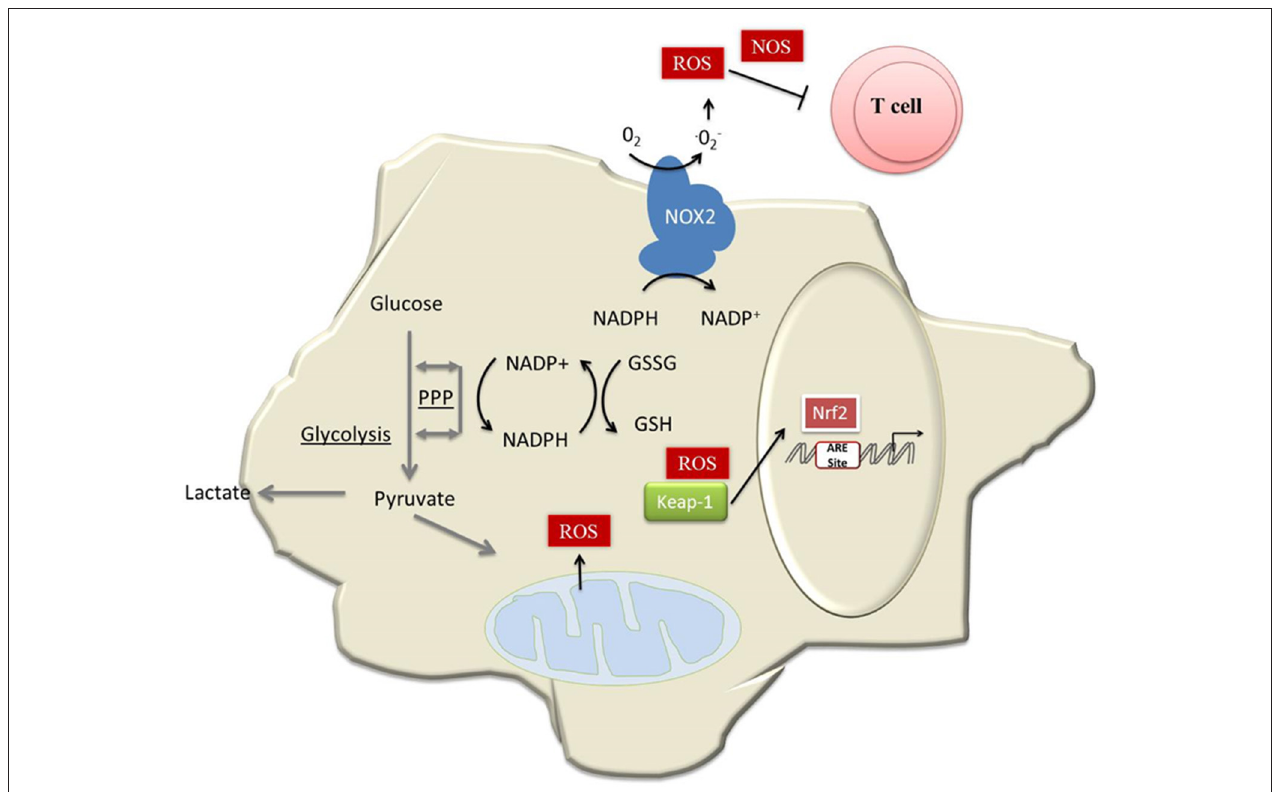
FIGURE 1 | Model of how MDSCs maintain redox homeostasis. Activated MDSCs produce high amounts of ROS molecules by the action of NOX2 (4). This, in addition to mitochondrial ROS and ROS derived from cancer cells, compromises redox homeostasis in MDSCs and most likely induces apoptosis in the absence of Nrf2 ( 21). Another consequence of Nrf2 activation, besides expression of antioxidative genes, is a metabolic reprogramming of MDSCs. This leads to enhanced expression of the PPP ( 22), which provides GSH. GSH not only serves as a major antioxidant, but is essential for MDSC differentiation (22). In addition, MDSCs counteract OXPHOS-derived ROS by upregulation of glycolysis